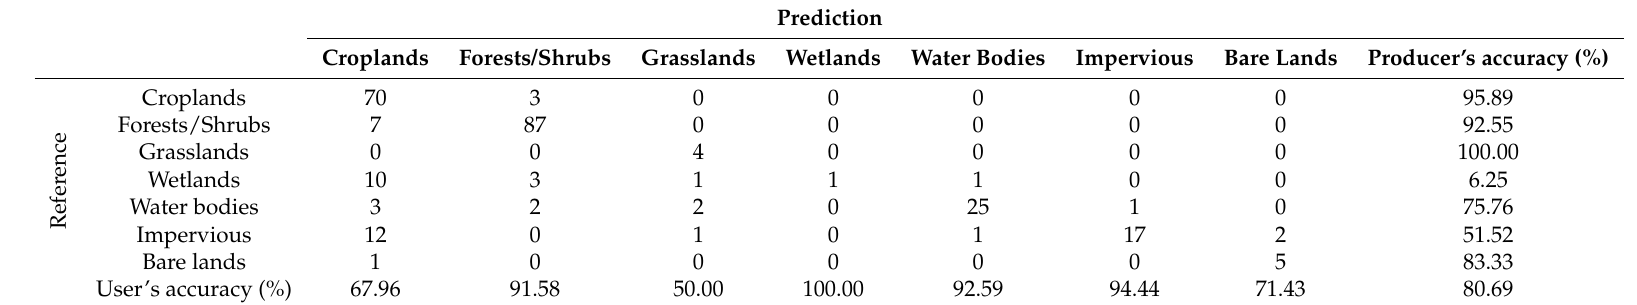
Table 2. Confusion matrix for the integrated land cover map of 2000.